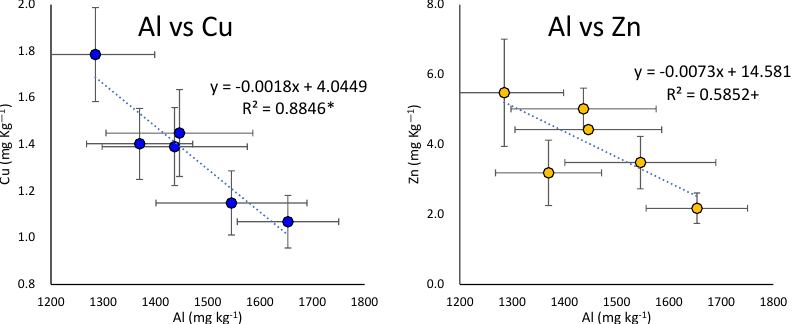
Figure 8. Relationships between soluble Al and exchangeable Ca and Mg in the ginseng cultivation soils. Mean values ± standard errors ( n = 3). * Represents significance at the 0.05 probability level. ** Represents significance at the 0.01 probability level. Figure 9. Relationships between soluble Al and exchangeable Ca and Mg in the ginseng cultivation soils. Mean values ± standard errors ( n = 3). + Represents significance at the 0.10 probability level. * Represents significance at the 0.05 probability level.